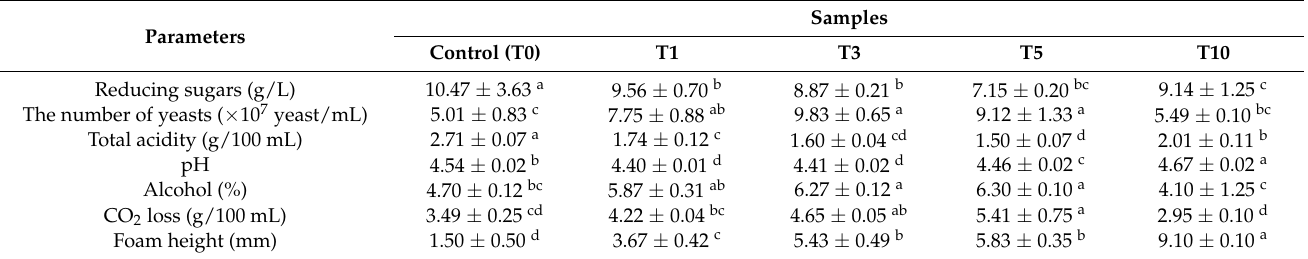
Table 1. Effects of D. officinale concentration on the growth and metabolism of Saccharomyces cerevisiae *.